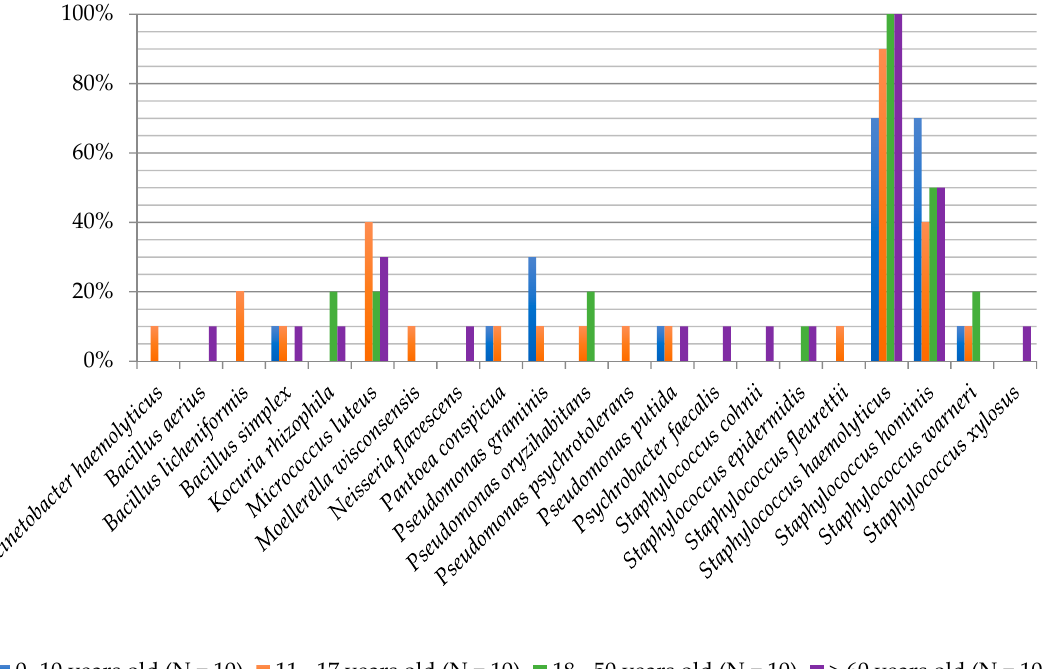
Figure 3. Frequency of the occurrence of bacteria on the foot skin depending on the age of examined people.